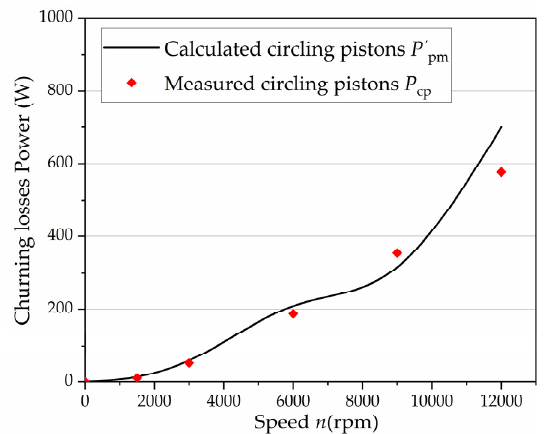
Figure 11. Comparisons between the experimental results and the results from the expression of churning losses with the reduction coefficient for multi-pistons.